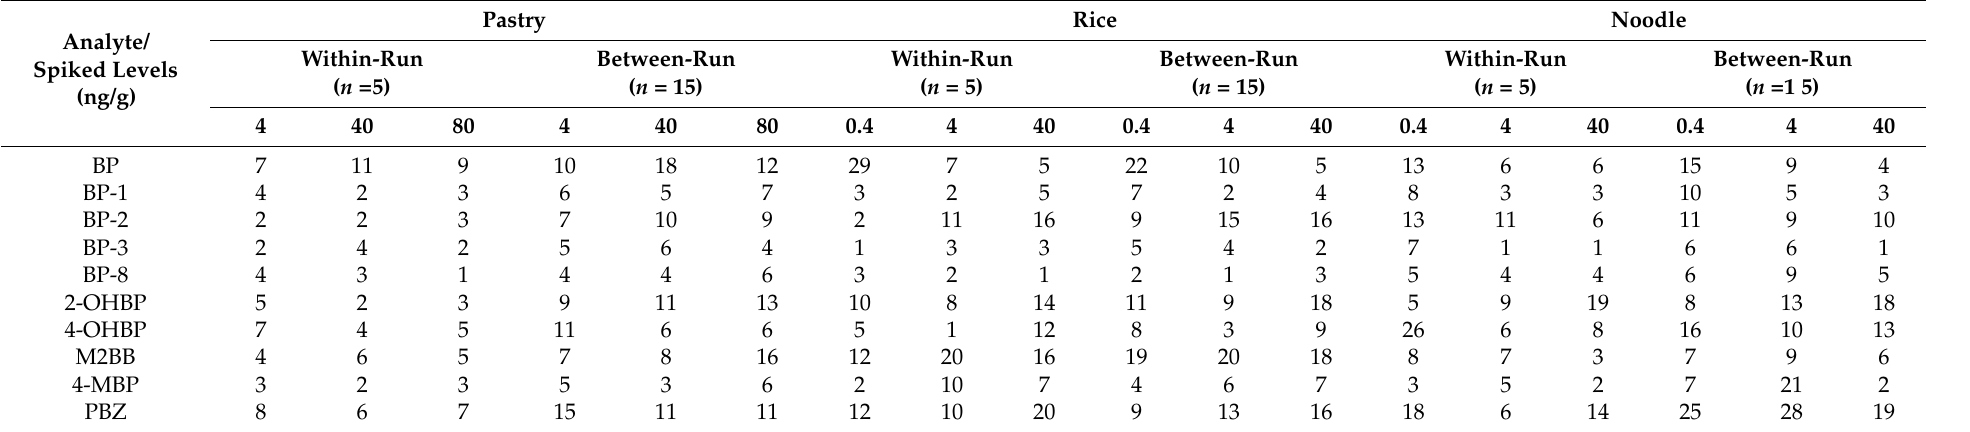
Table 5. Within-run and between-run precisions (%RSD) in spiked pastry, rice, and noodle samples.